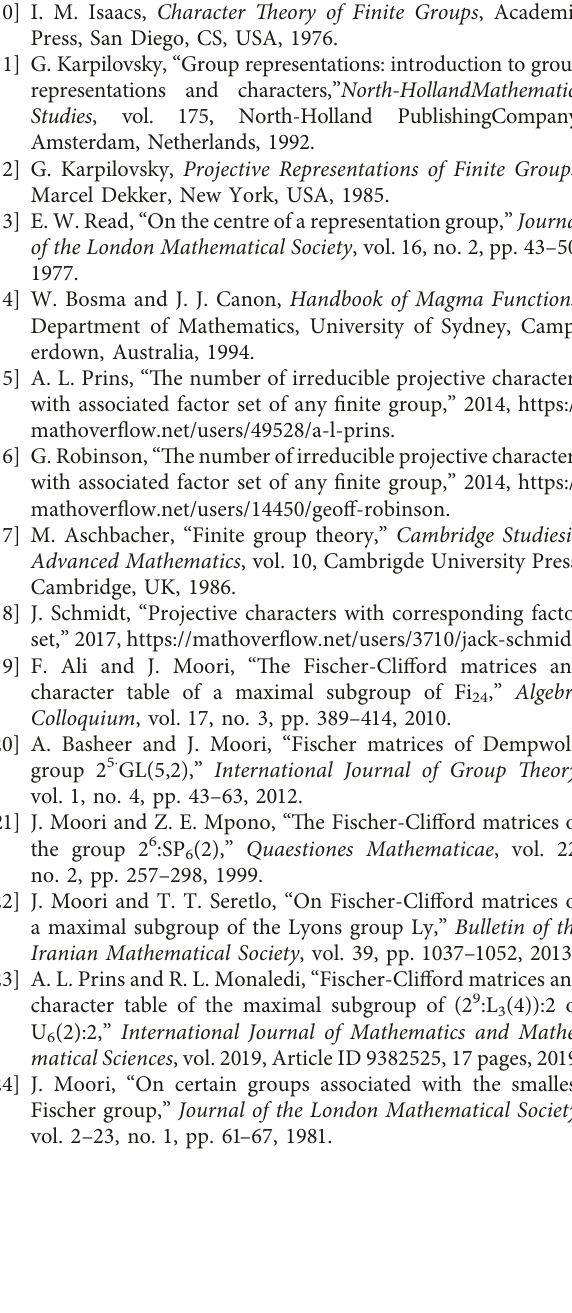
character table of the maximal subgroup of (2 9 :L 3 (4)):2